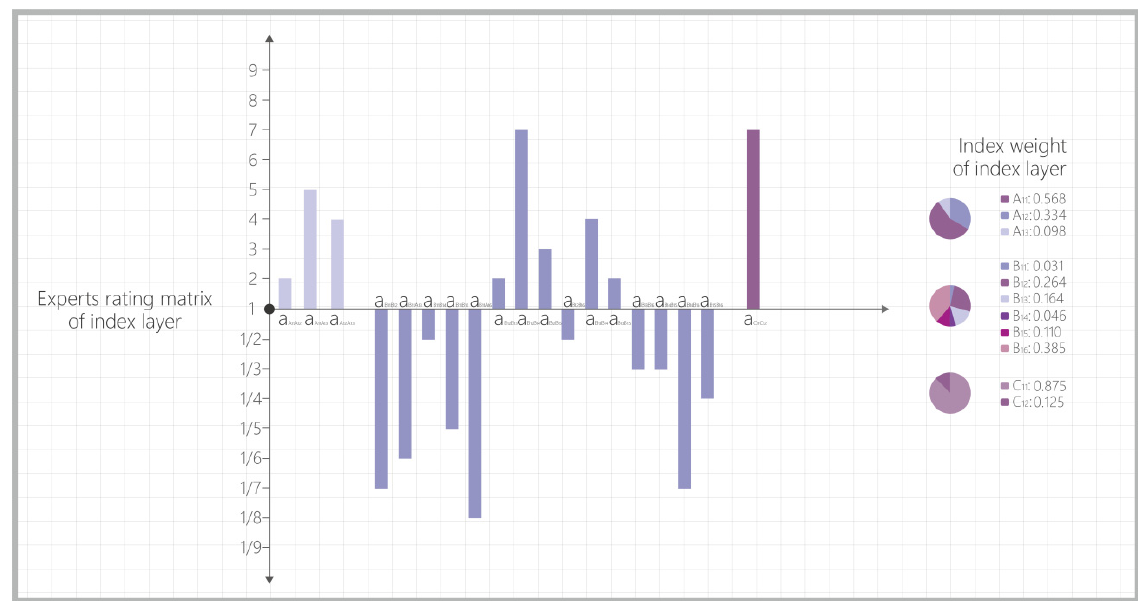
Figure 8. Experts’ rating judgment and index weight of index layer.